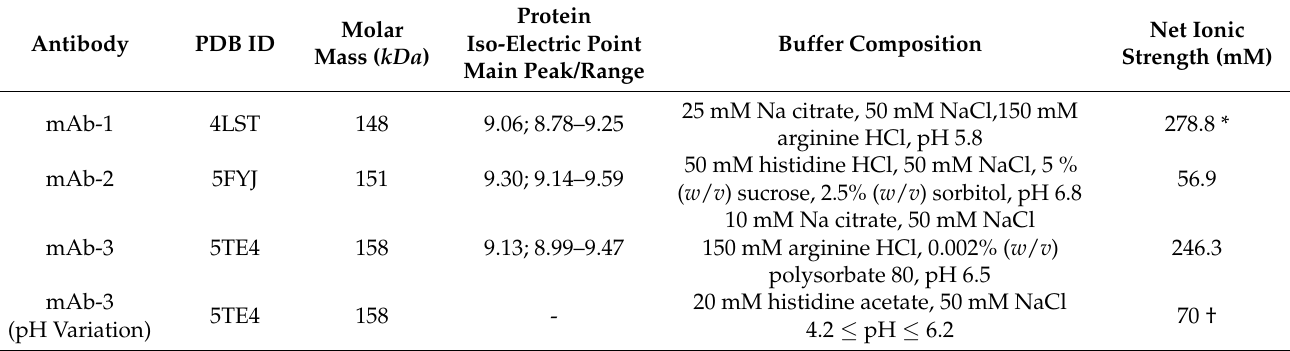
Table 1. Monoclonal antibodies (mAbs) and formulation buffer